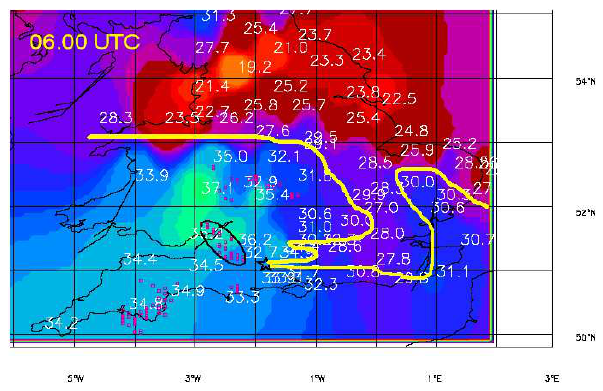
Fig. 3e. GPS integrated water vapour processed by the Met Of- fice/University of Nottingham system, 24 June 2005, 06:00UTC. Contours for values of IWV in kgm − 2 . Yellow contour is the limit of air with less than 30kgm − 2 in southern England. Black star is location of Larkhill, black ellipse encloses the lightning activity which passed just to the northwest of Linkenholt. During the day the low values in northern England seemed inversely correlated to the thunderstorm activity in southern and central